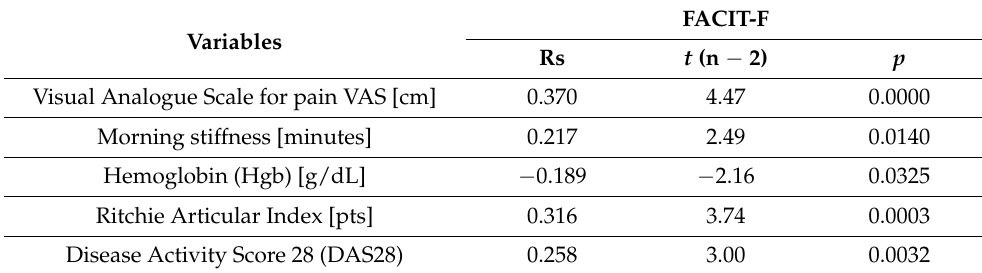
Table 4. The results of the significance test of Spearman’s rank correlation coefficient between the independent variables and the FACIT-F